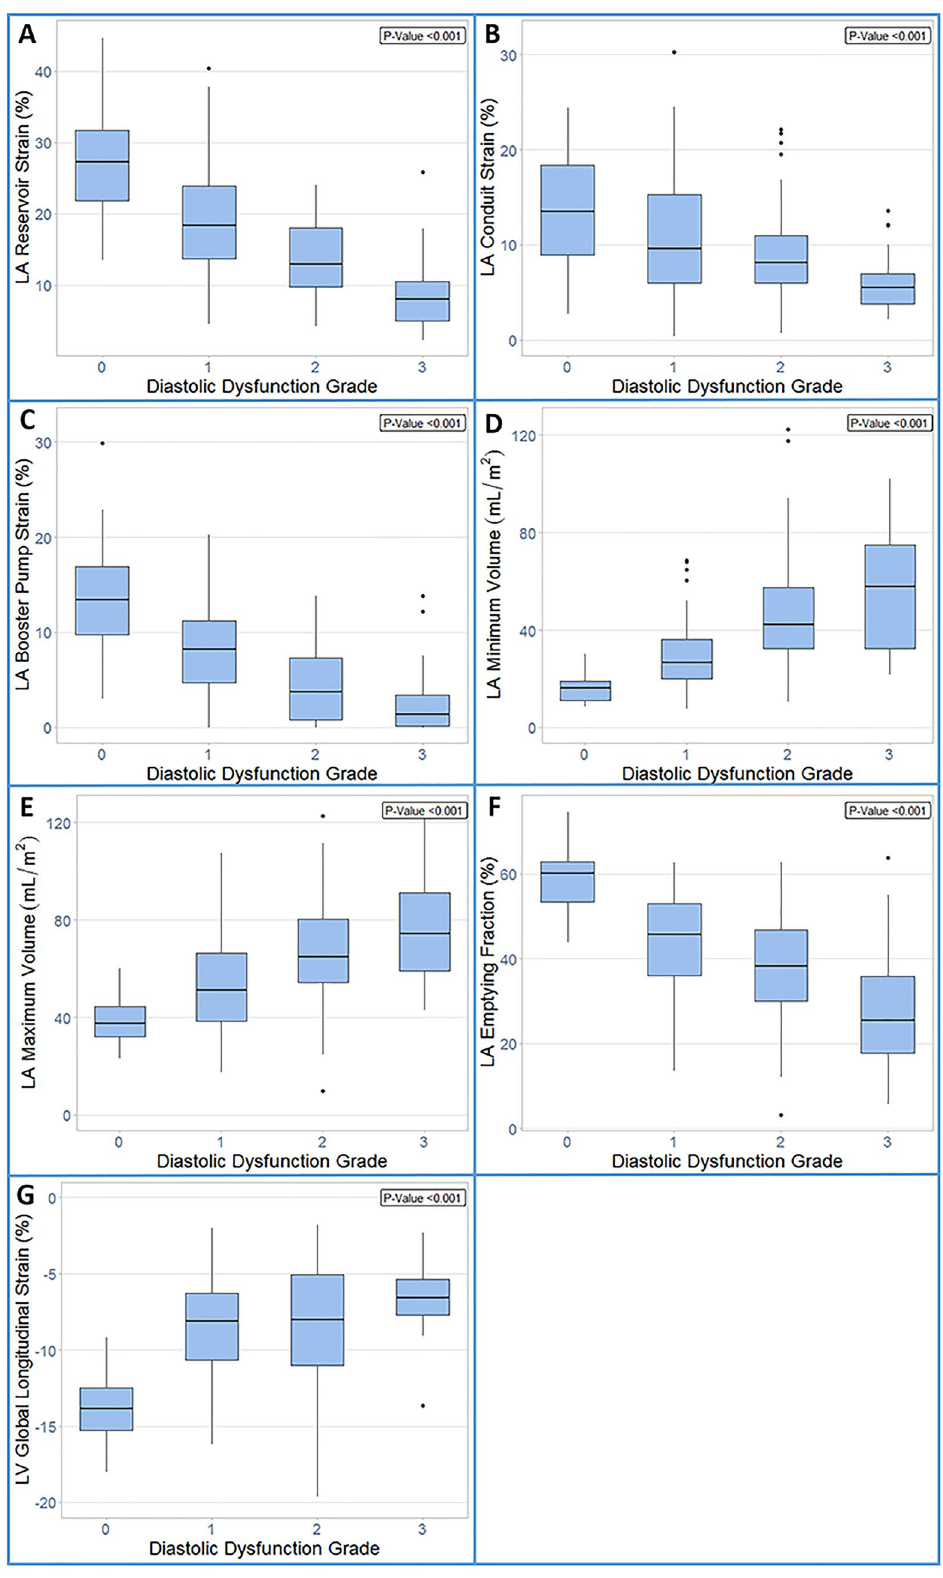
Figure 2. The graded change of left atrial reservoir strain ( A ), left atrial conduit strain ( B ), left atrial booster pump strain ( C ), left atrial minimum volume ( D ), left atrial maximum volume ( E ), left atrial emptying fraction ( F ), and left ventricular global longitudinal strain ( G ) in relation to the severity of left ventricular diastolic dysfunction. ANOVA with post-hoc Dunnett’s test yielded statistically significant differences between the means ( p < 0.05) in each